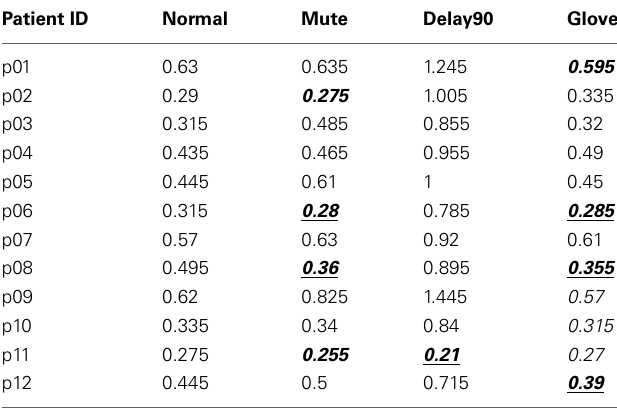
Table 1 | Individual mean IOI CVs of all the patients in Experiment 2. Patient